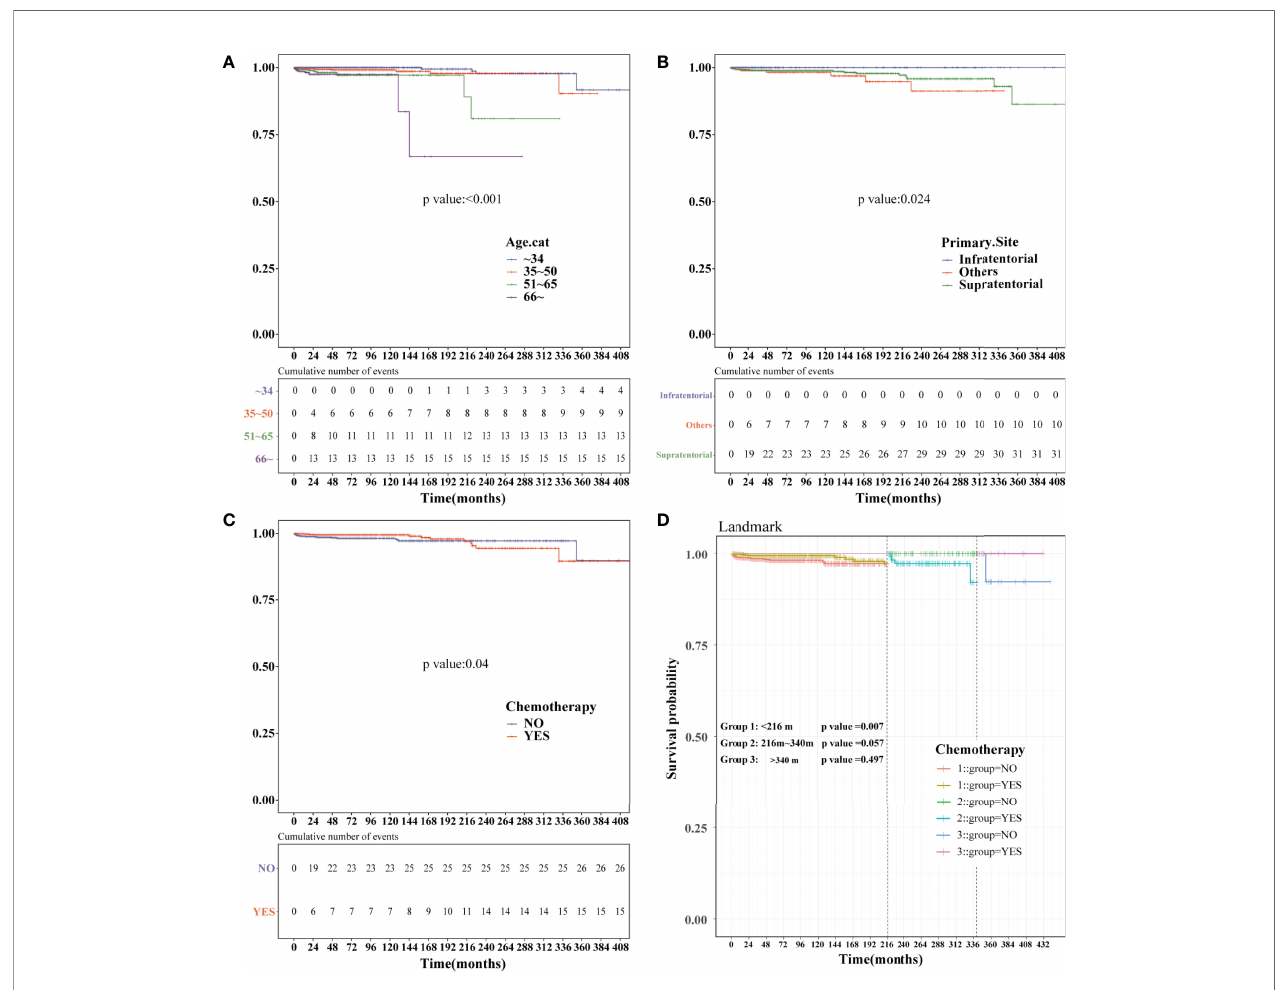
FIGURE 7 | Kaplan – Meier and landmark analysis of HDSS in the PSM-after cohort. HDSS curves of anaplastic astrocytoma patients strati fi ed according to (A) age at diagnosis, (B) primary site and (C) chemotherapy based on the Kaplan – Meier method. (D) Landmark analysis of HDSS strati fi ed according to chemotherapy in the PSM-after cohort at 216 and 340